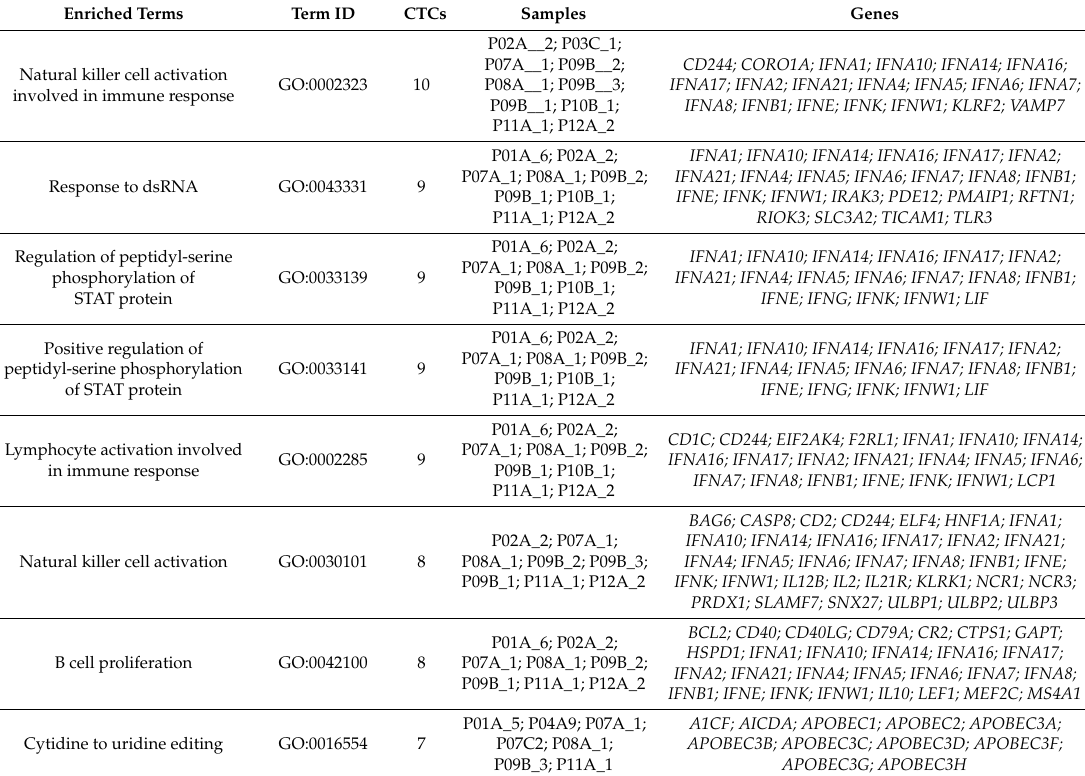
Table 3. List of the enriched terms in